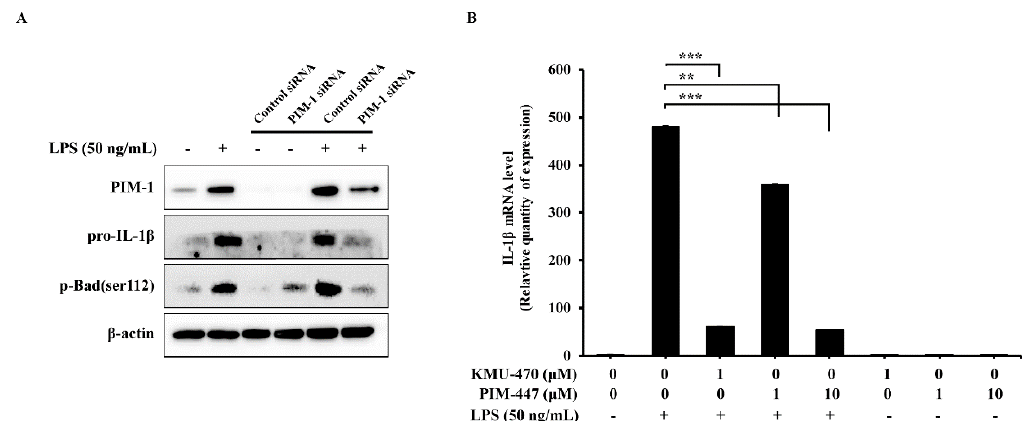
Figure 2. Effect of PIM inhibition on lipopolysaccharide (LPS)-mediated inflammatory response in RAW 264.7 cells. ( A ) RAW 264.7 cells transfected with negative siRNA or PIM-1 siRNA for 72 h and then treated with LPS (50 ng/mL) for 6 h. Whole cell lysates were isolated and used to measure the protein expression levels of PIM-1, pro-IL-1β, p-Bad, and β-actin by Western blot analysis. ( B ) Cells were treated with LPS (50 ng/mL) for 6 h after pre-treatment with different doses of KMU-470 (0.1, 0.5, and 1 μM) and PIM-447 (1 and 10 μM) for 1 h. Total RNA was isolated, and used to measure the mRNA expression levels of IL-1b and β-actin by RT-PCR analysis. *** p < 0.001, ** p < 0.01.